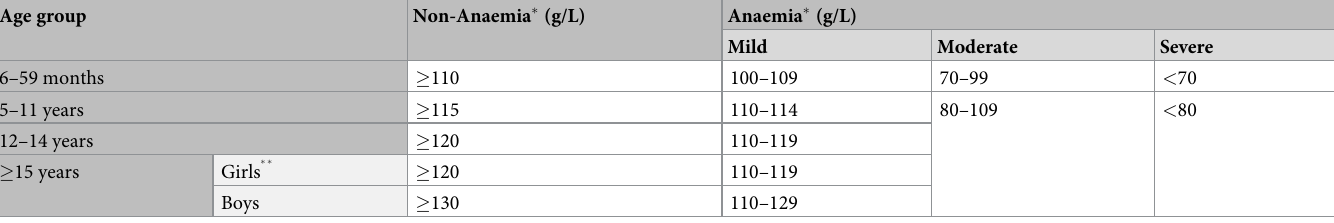
Table 3. Classification of anaemia severity at sea level based on measured haemoglobin concentrations by age